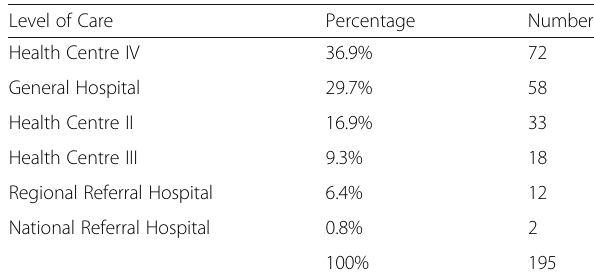
Table 4 Participating health facilities by level of care in